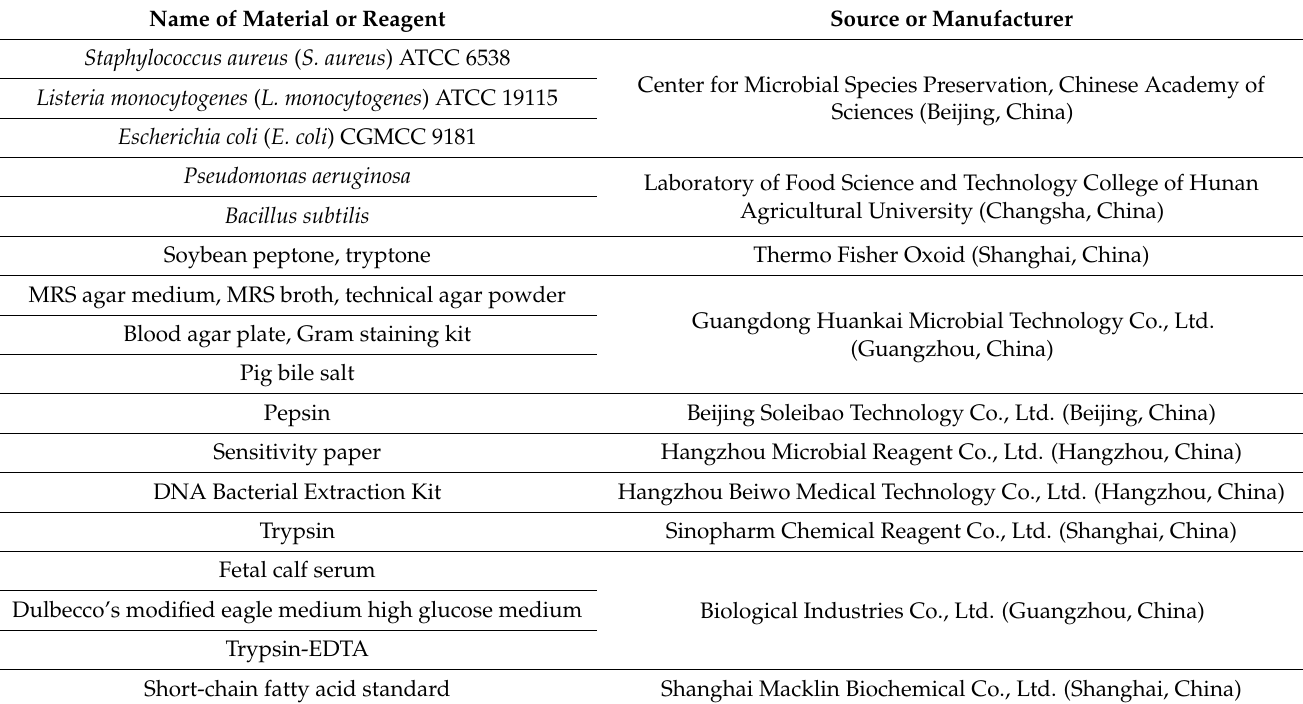
Table 1. Main reagents and